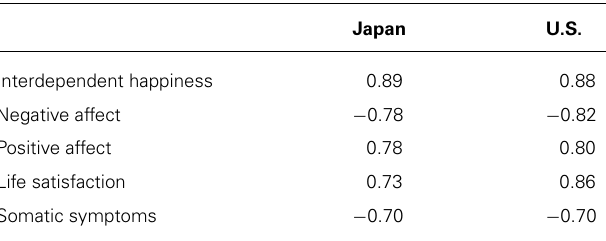
Table 1 | Principle component scores of SWB index in Japan and the U.S. (Study 1).